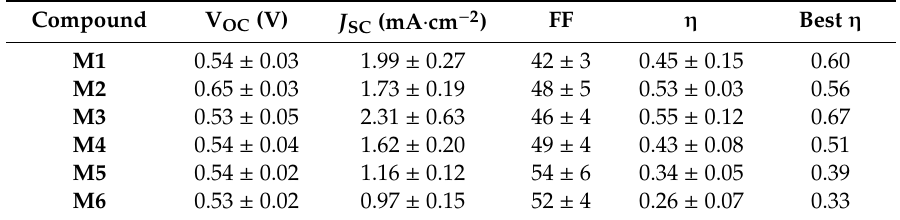
Figure 5. Current-voltage characteristics of ssDSSCs sensitized with chlorins M1 – M6 under illumination. Table 3. Photovoltaic parameters of ssDSSCs sensitized with chlorins M1–M6 and D102